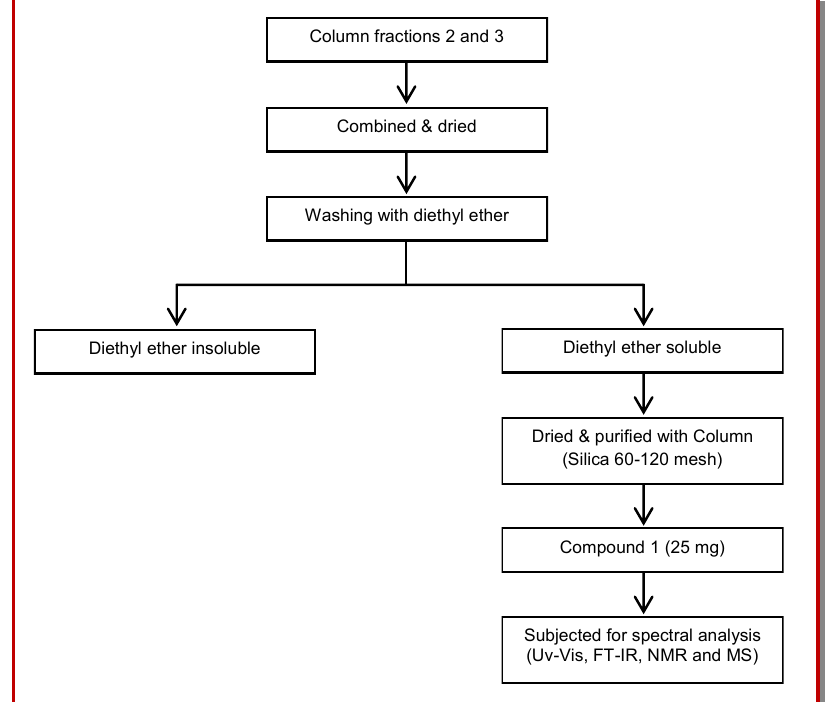
Figure 1: Flow chart for isolation of compound 1 from ethyl acetate extract of C.